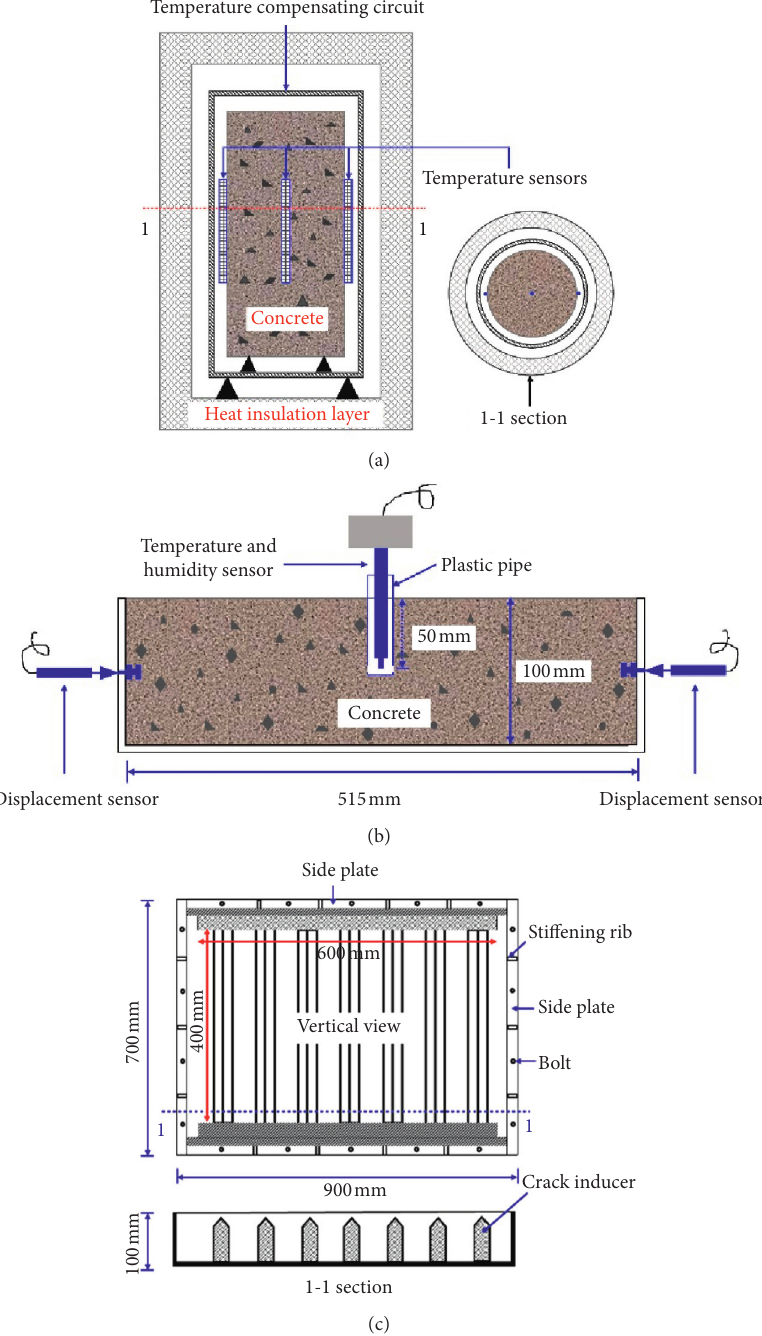
Figure 1: Schematic diagram of the test device. (a) Adiabatic temperature rise experiment for concrete. (b) Shrinkage experiment of concrete. (c) Slab cracking frame experiment of